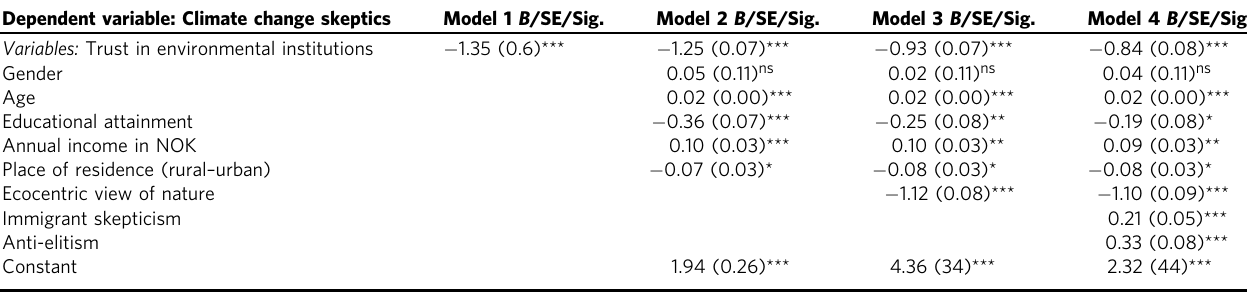
Table 3 Multippel logistic regressions